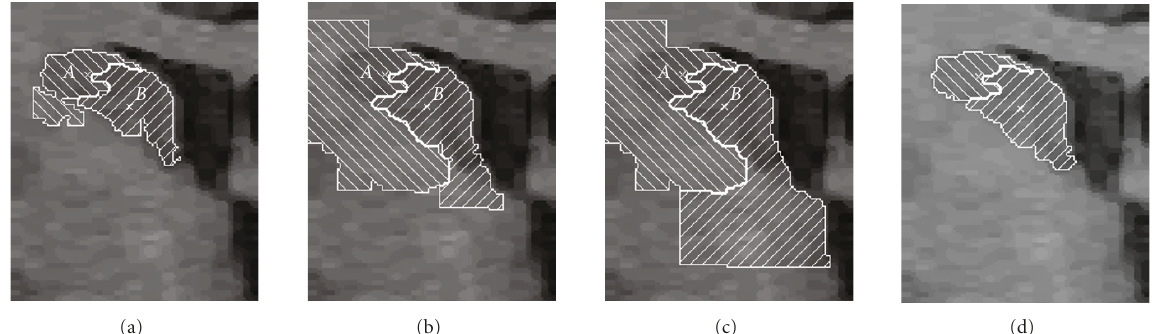
Figure 7: Segmentation of a caudate nucleus with two internal seeds, A and B . (a) The leaking occurs before the object be filled. (b) The moment when κ A = 324 is detected. (c) The instant when κ B is detected. (d) Final